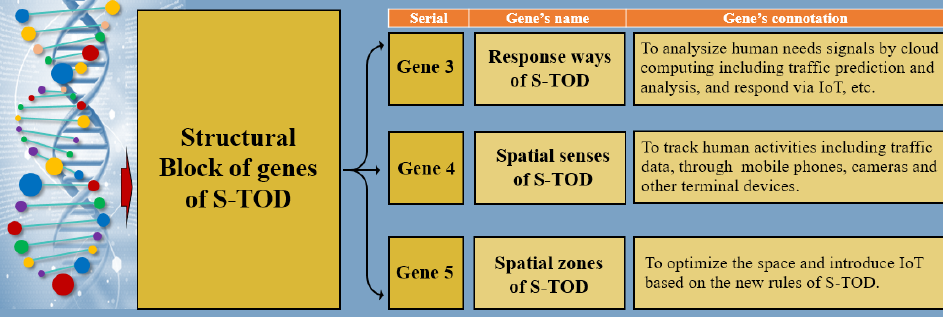
Figure 12. The structural genes of S-TOD.